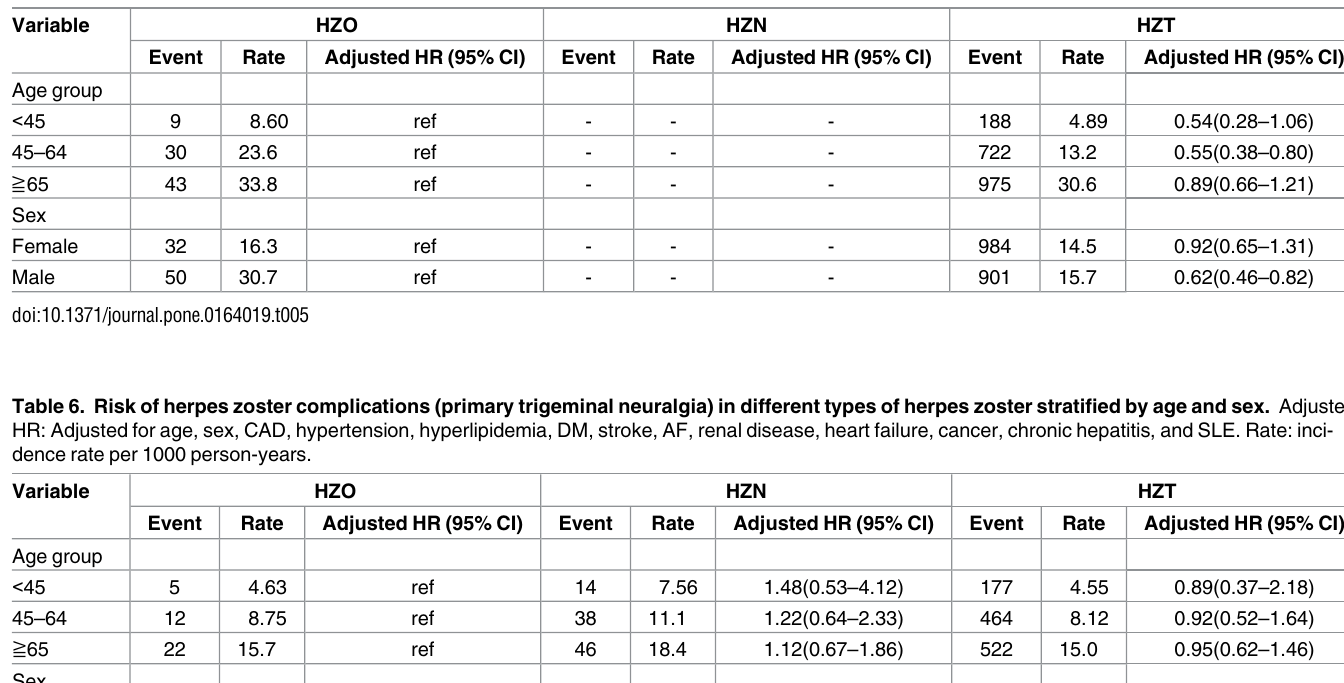
Table 5. Risk of herpes zoster complications (neurological) in different types of herpes zoster stratified by age and sex. Adjusted HR: Adjusted for age, sex, CAD, hypertension, hyperlipidemia, DM, stroke, AF, renal disease, heart failure, cancer, chronic hepatitis, and SLE. Rate: incidencerate per 1000 person-years.